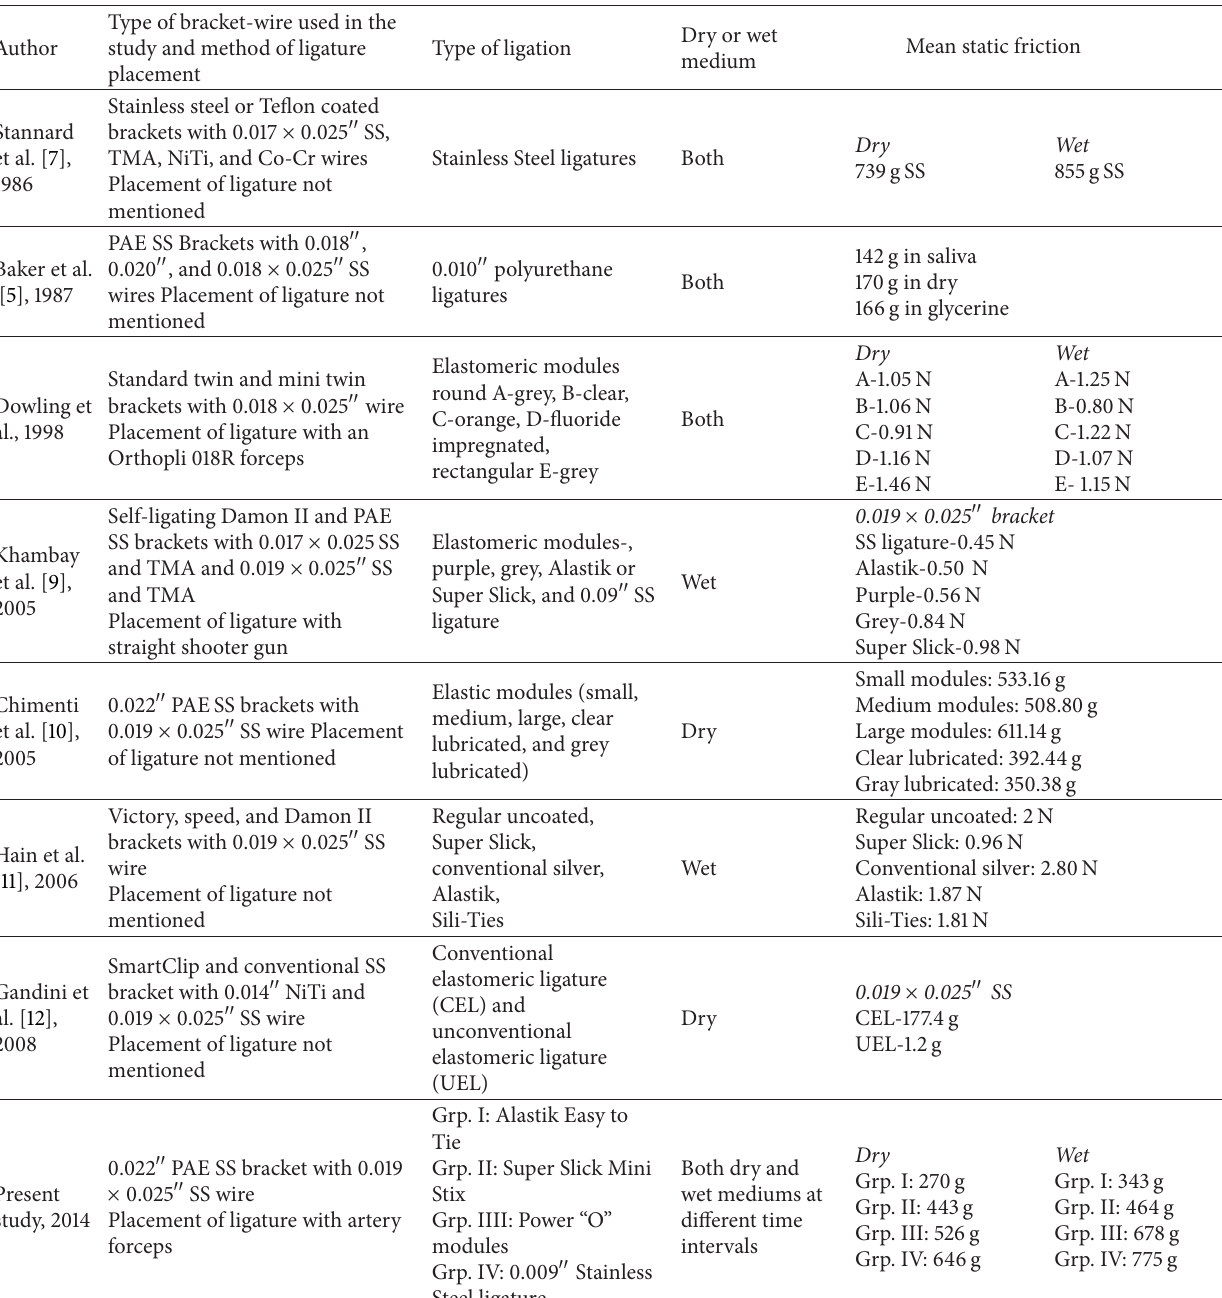
Table 4: Comparison of mean static friction found in other studies quoted and results obtained in the present study. A comparative evaluation of static frictional